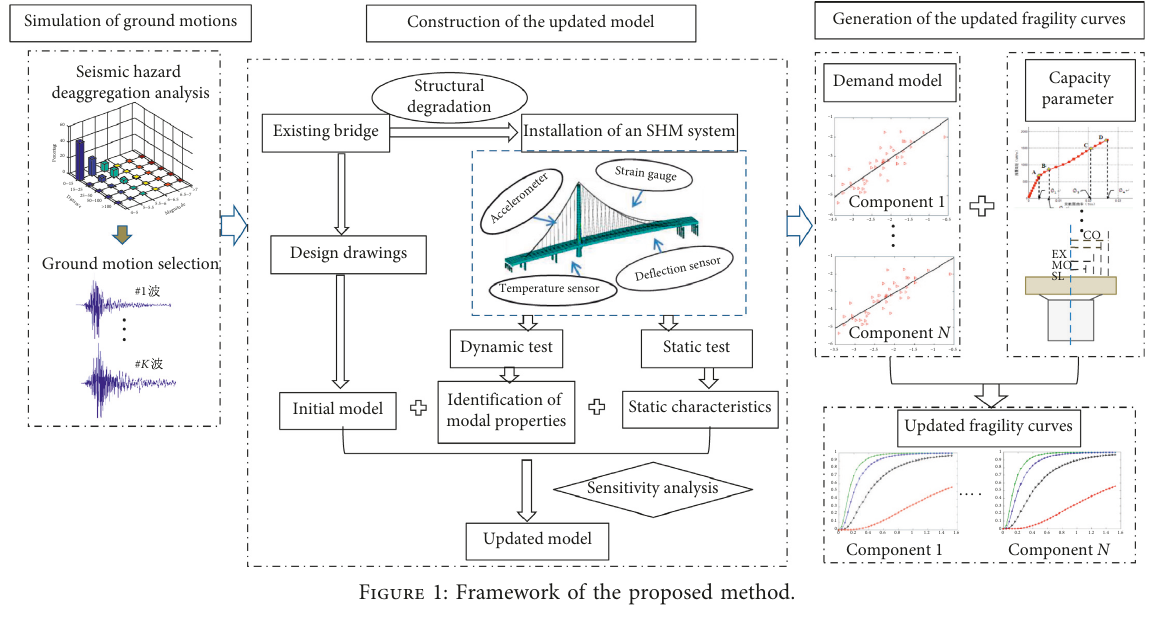
Figure 1: Framework of the proposed